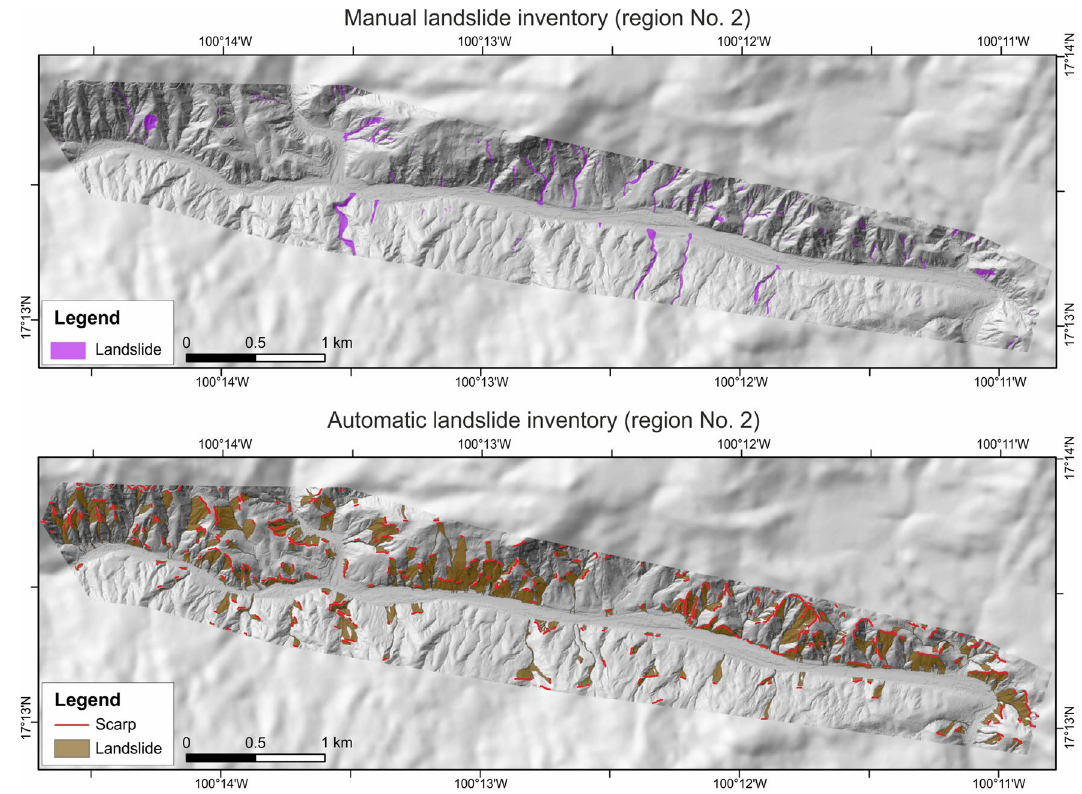
Figure 3. Landslides identified in region No. 2 using two approaches, including manual mapping using satellite images and automatic identification of landslide morphology employing CCM algorithm on shaded relief of LIDAR derived DTMs. Maps were generated using ArcMap 10.2.2 software, copyright and licensed by ESRI (http:// deskt op. arcgis. com/ en/). The final layout was created in ArcMap 10.2.2 (http:// deskt op. arcgis. com/ en/) and CorelDRAW 2018 (https:// www. corel draw. com/